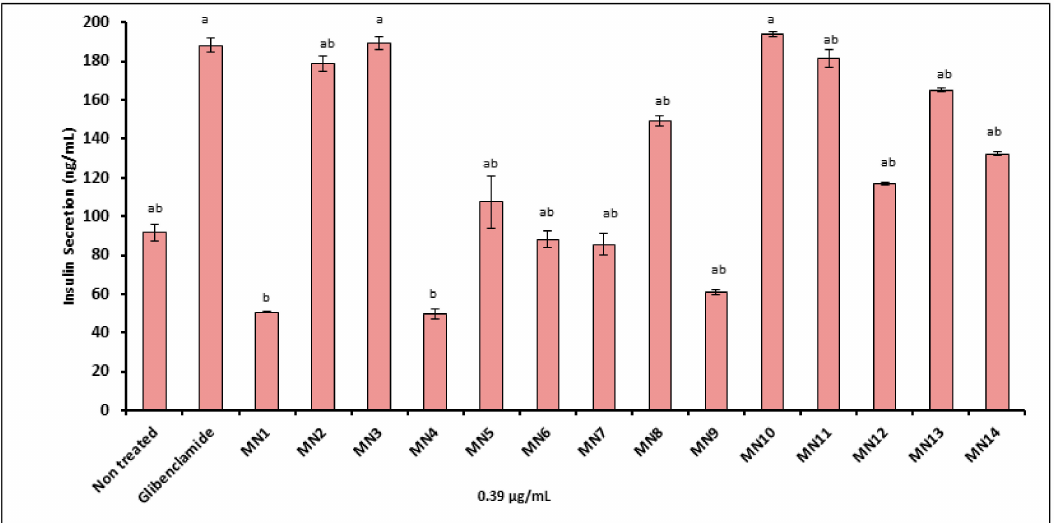
Figure 4. The effect of the flavonoid on insulin secretion activity of RIN-5F pancreatic cells. Mean ± S.D., n = 3, means that do not share a letter are significantly different ( p <